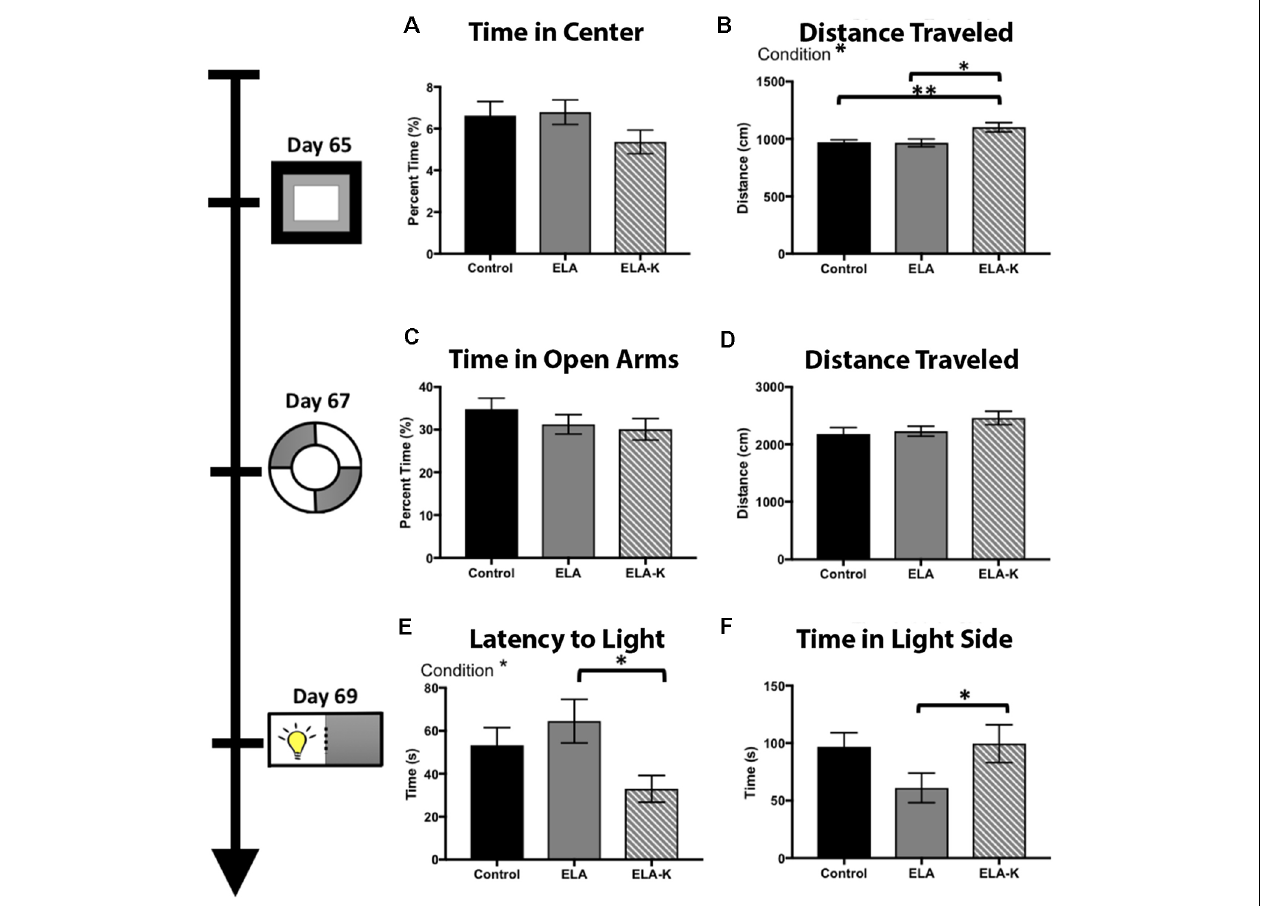
FIGURE 5 | Effects of early life adversity (ELA) in the form of LBN rearing and LBN with kicking (LBN-K) on anxiety-like behaviors of adult offspring. (A) No significant effect of group was found for time in center of the arena ( F ( 2,118 ) = 0.77, p = 0.46) on the open field test. (B) LBN-K mice travel greater distance than other groups ( F ( 2,120 ) = 3.70, p = 0.03) on the open field test. (C) No significant effect of group was found for time spent in open arms of elevated zero maze ( F ( 2,1102 ) = 0.021, 73 p = 0.9918). (D) No significant effect of group was found for distance traveled on the elevated zero maze ( F ( 2,112 ) = 1.73, p = 0.18). (E) A significant effect of condition was found for latency to first enter the light side of the light:dark box ( F ( 2,66 ) = 3.176, p = 0.048). ELA-K adult mice entered significantly earlier than ELA animals ( t ( 34.5 ) = 2.644, p = 0.01). (F) No main effect of condition was found for time in light side ( F ( 2,71 ) = 2.43, p = 0.096), but ELA animals spend less time in the light compared to controls ( t ( 49.1 ) = 2.03, p =